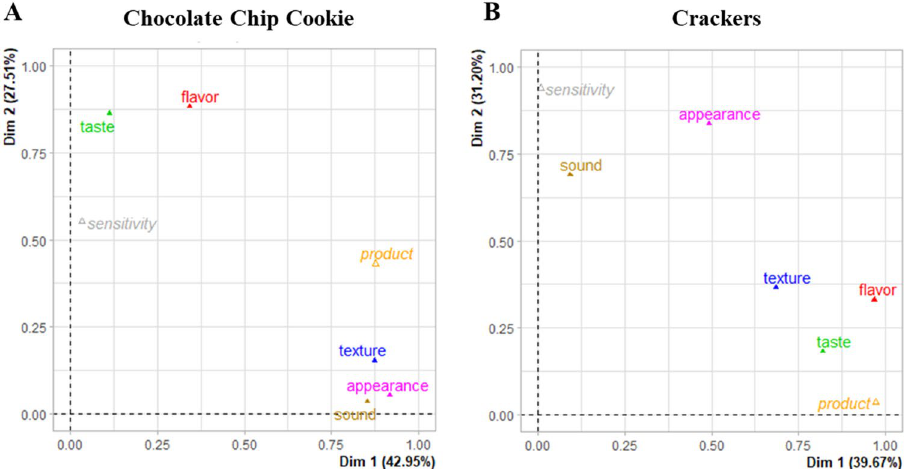
Figure 4. Weighting of sensory term types by sensitivity group and products by products. Two dimensions describe 70% of the space for each product in which the first dimension describes agreement in term types between groups of touch sensitivity and the second-dimension disagreement in term types. ( A ) and ( B ) shows the terms differ among groups, but they are dependent on the food and are not specific to